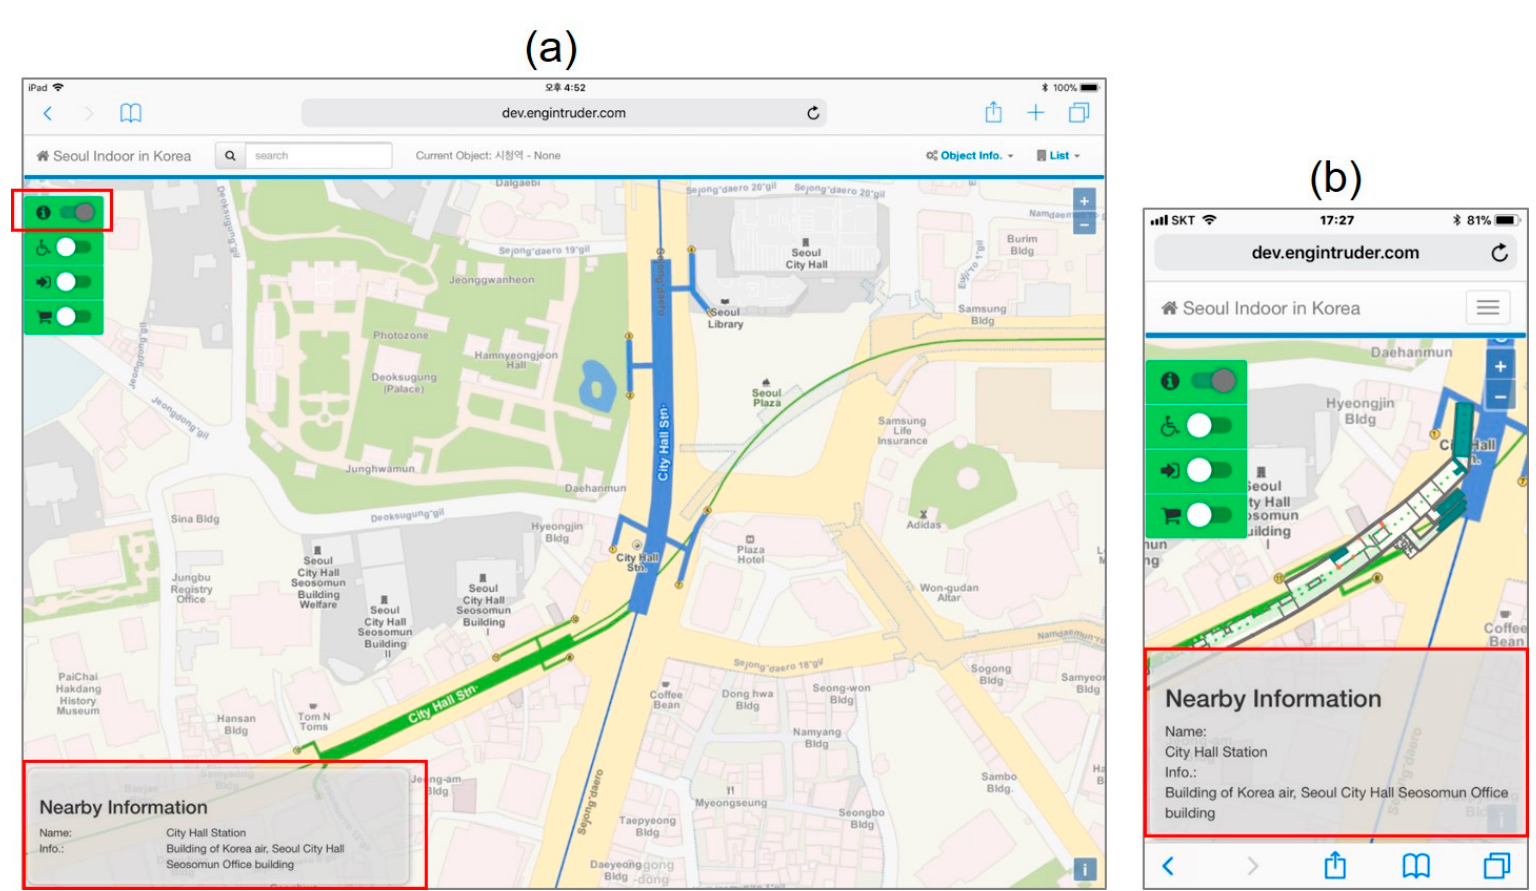
Figure 11. Visualization results of indoor POI detailed information: ( a ) entrance, ( b ) handicap facility, and ( c ) shopping center.